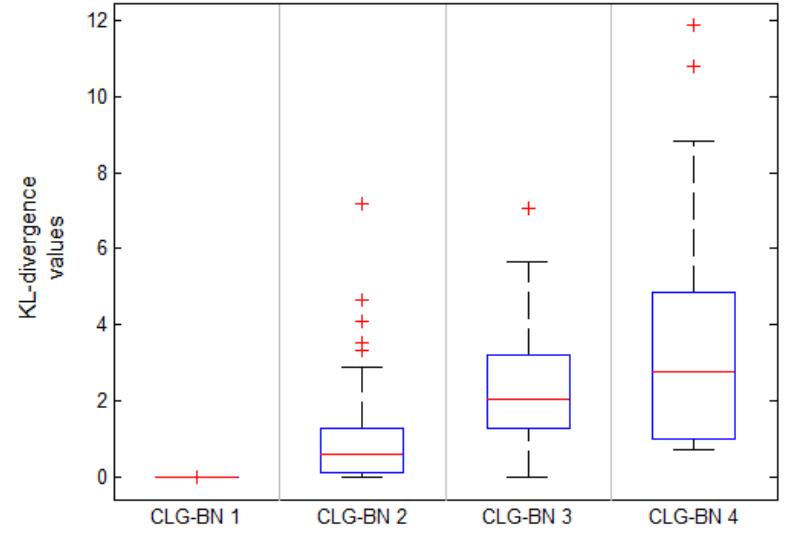
Figure 7. Accuracies for convergence on the four CLG